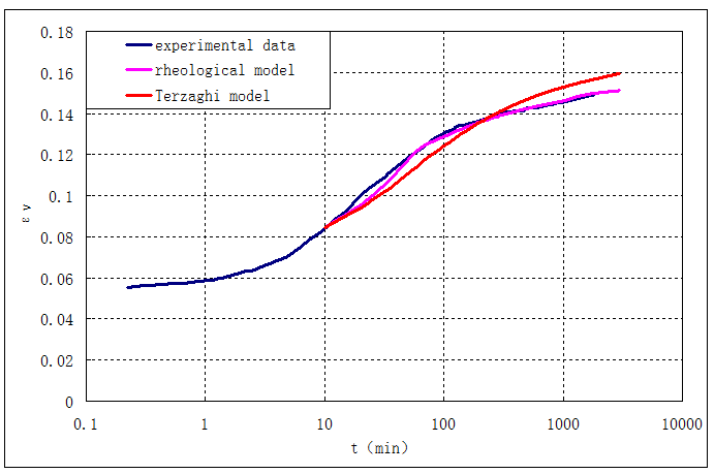
Figure 6. Comparison graph of clay strain value and